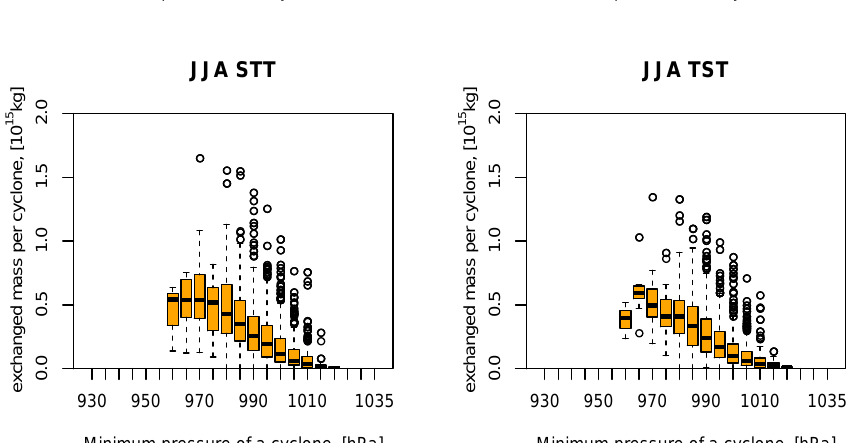
340 . 7 and 254 . 2kgkm − 2 s − 1 for STT and TST,